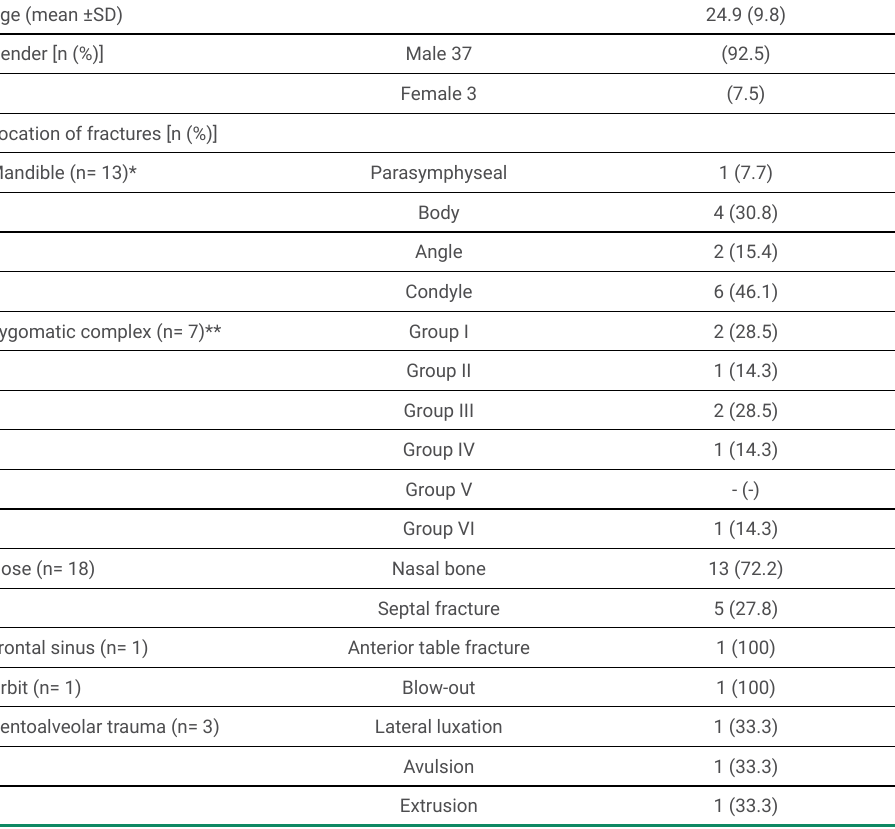
Table 1 . Demographic and fracture characteristics of patients with sports-related maxillofacial fractures (n=